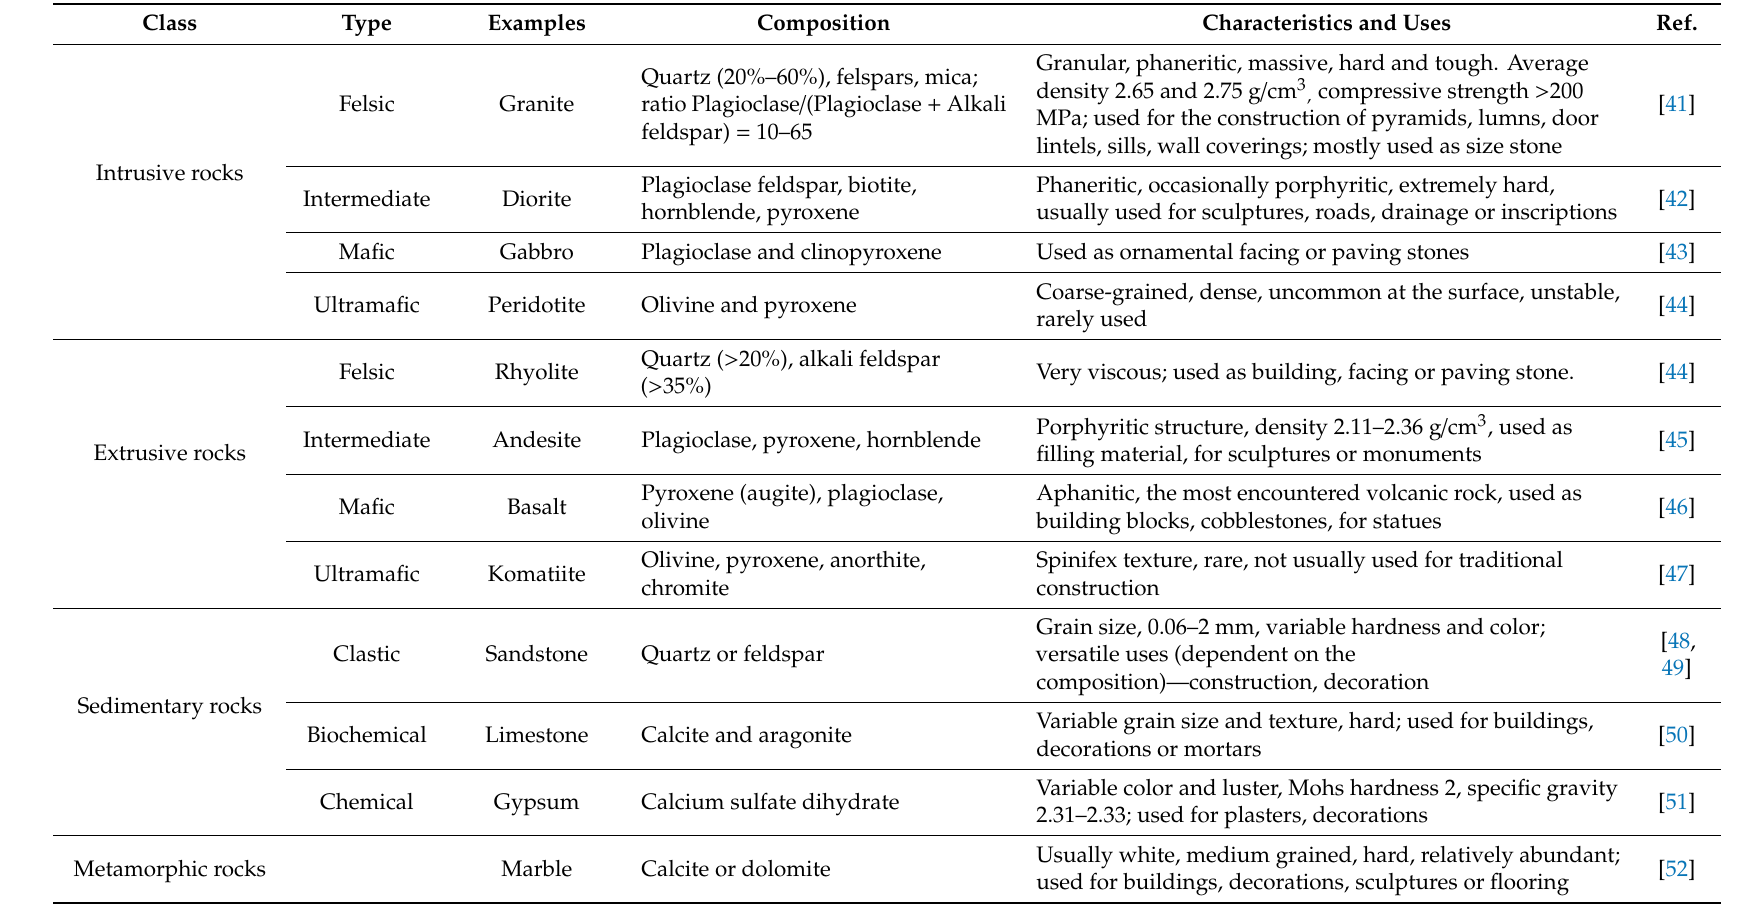
Table 2. Characteristics of natural rocks used in vernacular